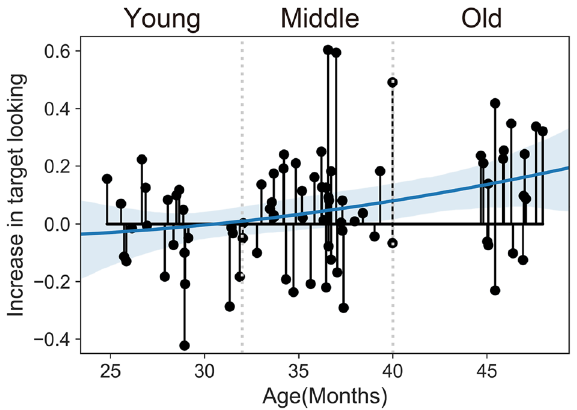
Figure 1. Subject mean values in target-looking increase for three age groups. All data were calculated over 367- to 4000-ms time windows. Toddlers in the young group (24–32 months) did not significantly fixate on sound-matched hiragana letters. However, index for toddlers in the middle (32–40 months) and the old (40– 48 months) groups significantly exceeded zero. The blue line indicated polynomial regression line (order = 2) with 95% confidence interval (light blue).